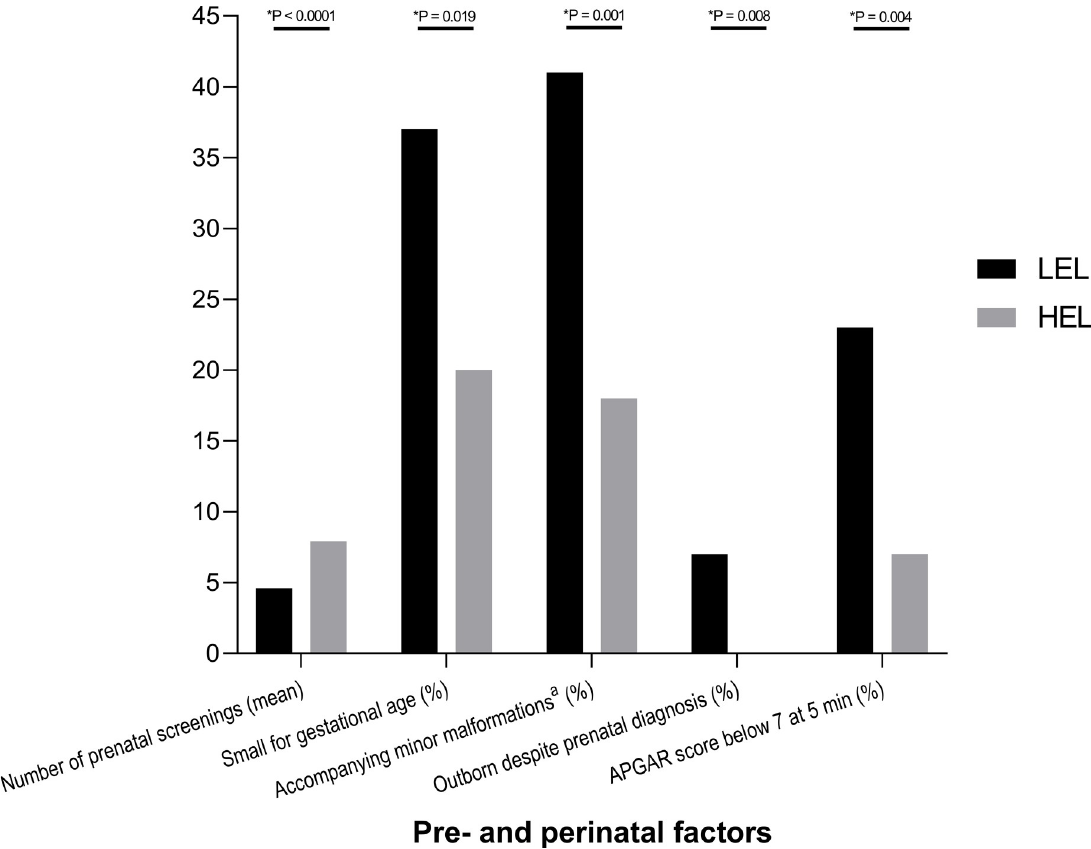
Fig 3. Pre- and perinatal conditions in patients with congenital malformations requiring surgical intervention. Data are shown as mean and standard deviation or percentage as indicated. P values were determined either by Student’s t-test or chi-square test as applicable. a minor malformations were defined as malformations and syndromes that did not require any additional intervention during the initial hospital stay, such as atrial or ventricular septal defect, dextrocardia, aplasia of the inferior vena cava with persistent azygos vein, truncus bicaroticus, trisomy 21 without cardiac defects except atrial or ventricular septal defects, Wiedemann-Beckwith-Syndrome, intestinal mal- or nonrotation, horseshoe or pelvic kidney, renal duplication, megaureter, hypospadia, polysplenia, butterfly vertebrae, cleft palate, unilateral vocal cord paralysis, septum pellucidum agenesis, and corpus callosum